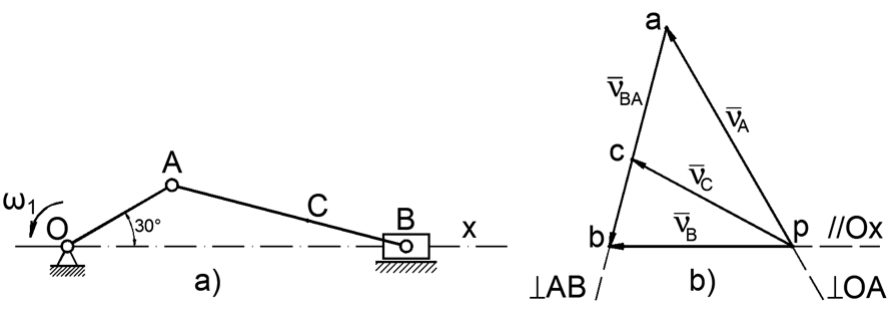
Figure 5. The velocity plan and the vector equations